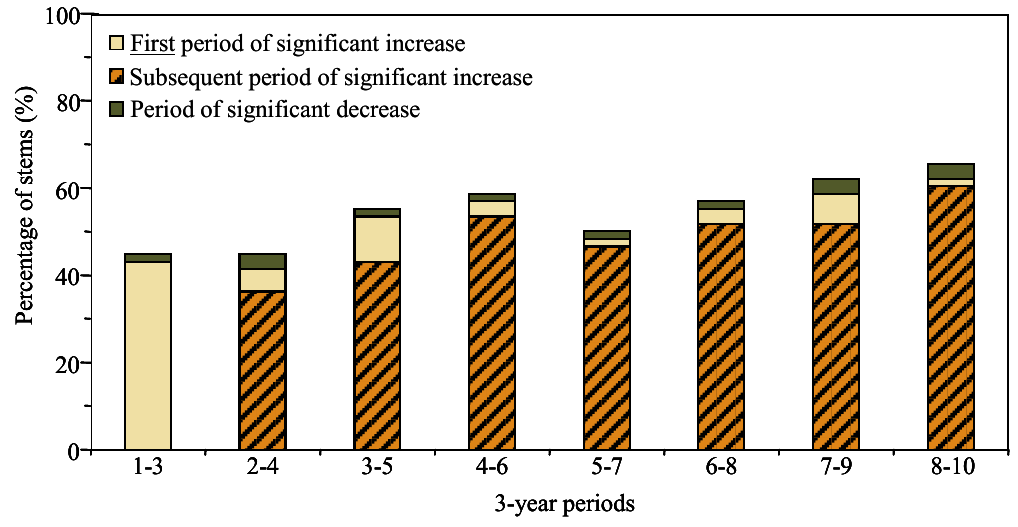
Figure 7. Distribution of northern white-cedar harvested stems showing a significant difference in GLD increment compared to the pre- cutting period (years −3 to −1) of the Outaouais Region (OR site) and Papineau-Labelle wildlife reserve (PL site). Time of harvest = year